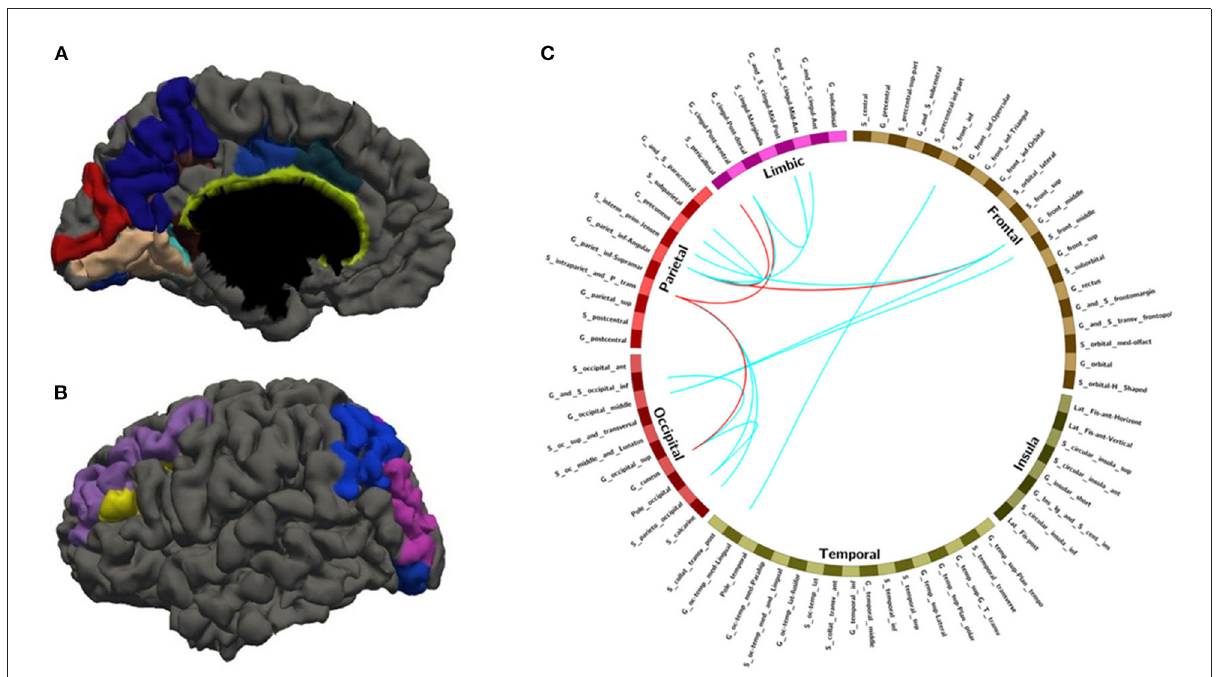
FIGURE5 The overlapped ROIs and edges in both approaches (A,B) Regions involved in 28 FC features with overlapping ratios ≥ 12/14 across 14 training sessions. (C) Edges involved in 28 FC features with overlap ratio ≥ 12/14 in 14 training sessions. Red line: feature mean functional connections greater than the remaining 75% are marked with a red line. Blue line: no more than the remaining 75% of the feature mean functional connections are marked with blue